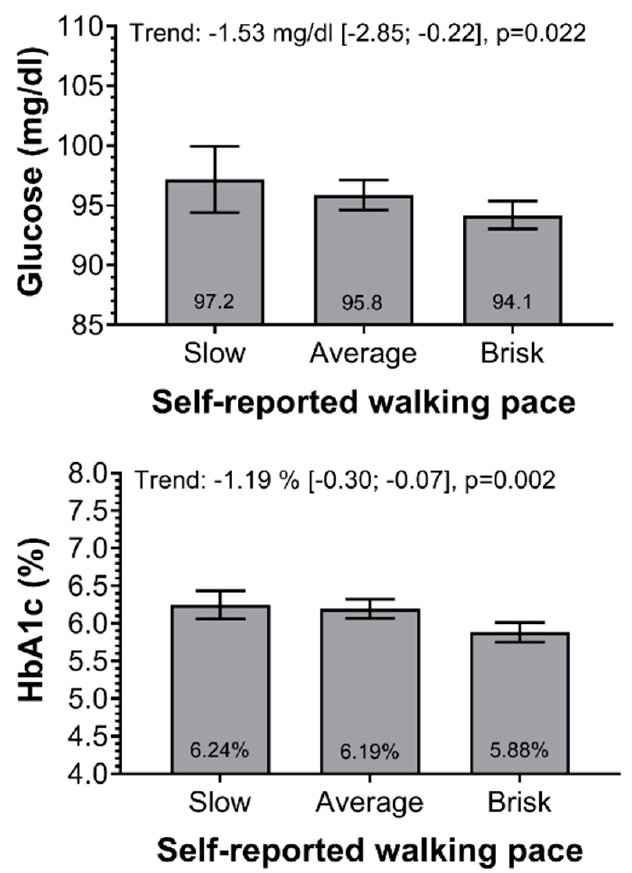
Figure 1. Association of walking pace with fasting glucose and HbA1c. Data presented as adjusted means and its 95% CI. Slow walking pace was considered as a reference value. Results were adjusted for model 3—age, sex, educational level and residence setting (urban / rural), BMI, smoking, alcohol, sleep duration, fruit and vegetable intake, and sitting time. The trends were estimated with regression analyses and presented as β -coefficient and 95% CI for the outcome per one category change in walking pace. HbA1c = Glycosylated Haemoglobin.